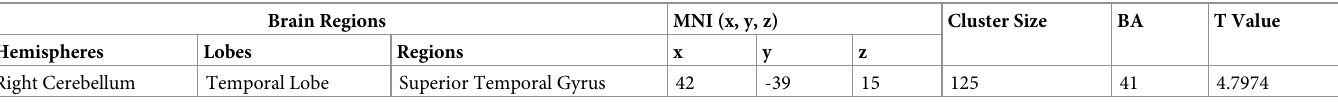
Table 2. Brain areas with significant ALFF differences between the breastmilk-fed group and the formula-fed